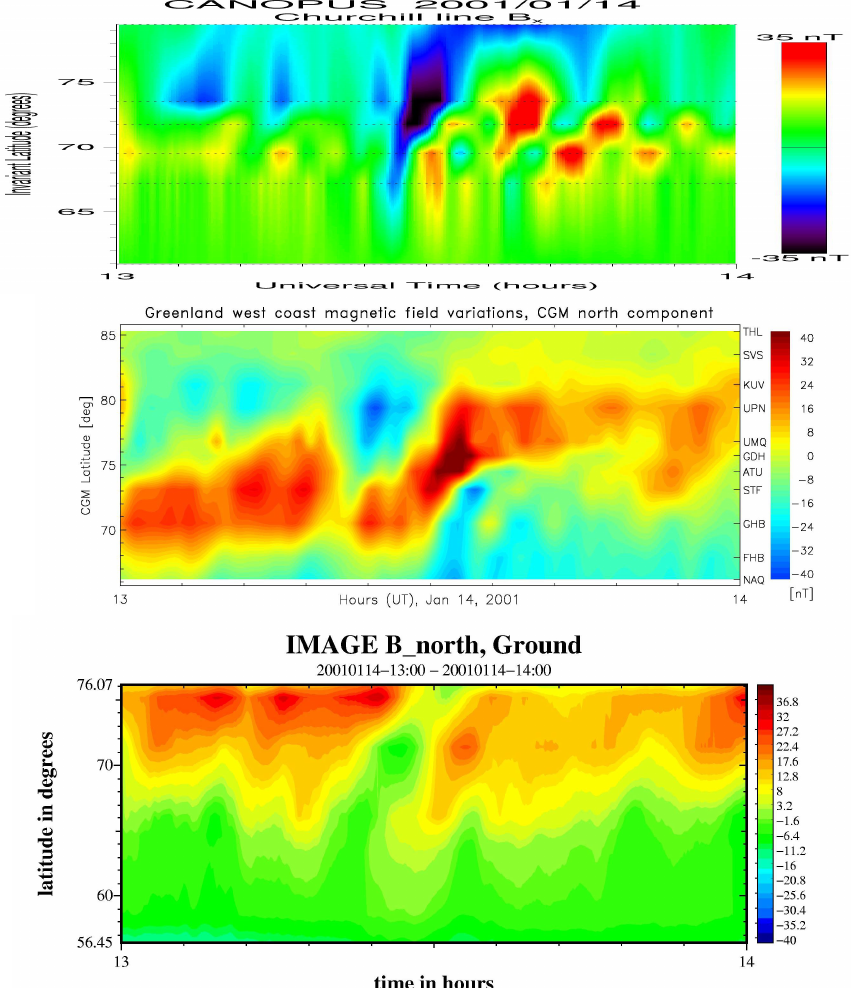
Fig. 9. Color-coded iso-contour plots of magnetic X -component disturbance on the ground as determined along mag- netic meridians central to the CANO- PUS (top panel), Greenland (central panel) and IMAGE (bottom panel) magnetometer networks. In these pre- sentations blue areas correspond to westward and red areas to eastward ionospheric current